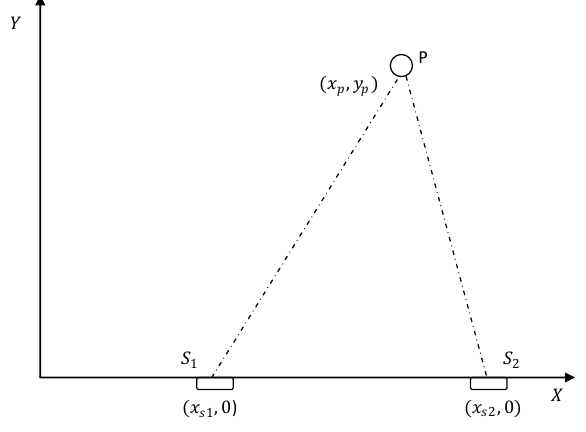
Figure 2. Localization with two sensors (AoA/Range) on